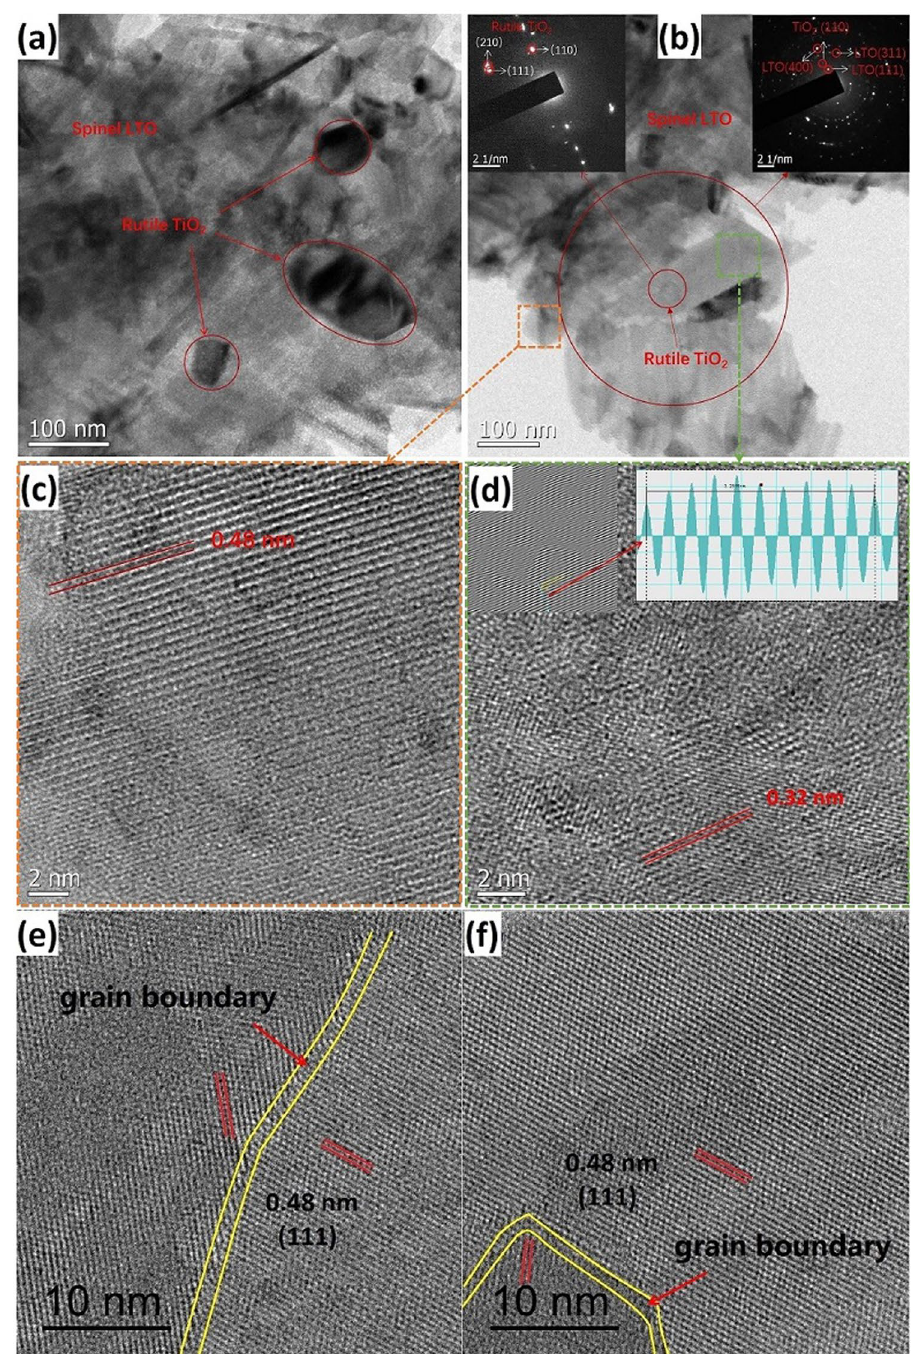
Figure 4. ( a , b ) TEM images and ( c – f ) HRTEM images of LTO-RT-AT. The insets in ( b ) show the SAED patterns. The yellow line areas in ( e ) and ( f ) show grain boundaries in the